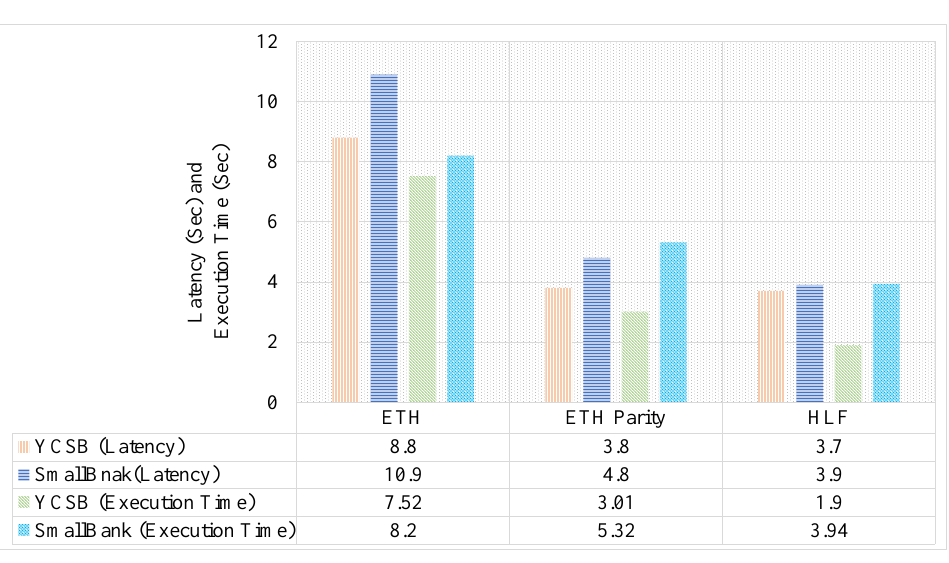
Figure 9. Latency and execution time comparison between ETH, ETH Parity, and HLF